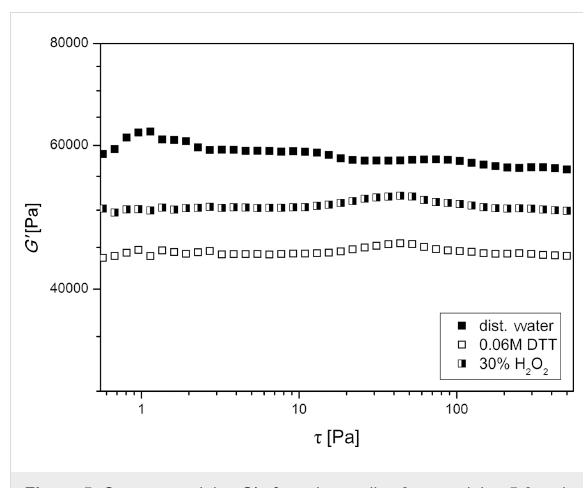
Figure 5: Storage modulus G’ of a polymer disc 6c containing 5.0 mol % CL 1 and 5.0 mol % CL 2 after being immersed in distilled water (full symbols), 0.06 M DTT solution (empty symbols) and 30% H 2 O 2 (half symbols).